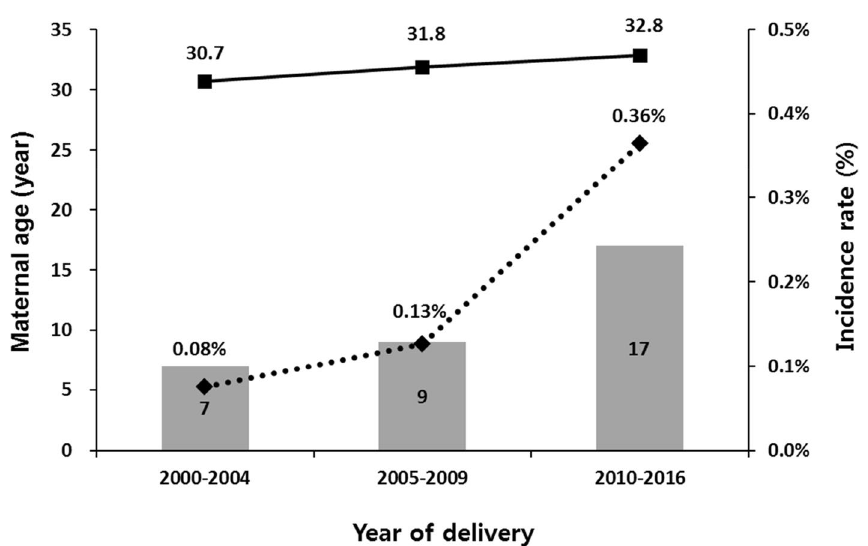
Figure 1. Maternal age (filled black square), number of cases (bar), and incidence rates (filled black diamond) of symphysis pubis